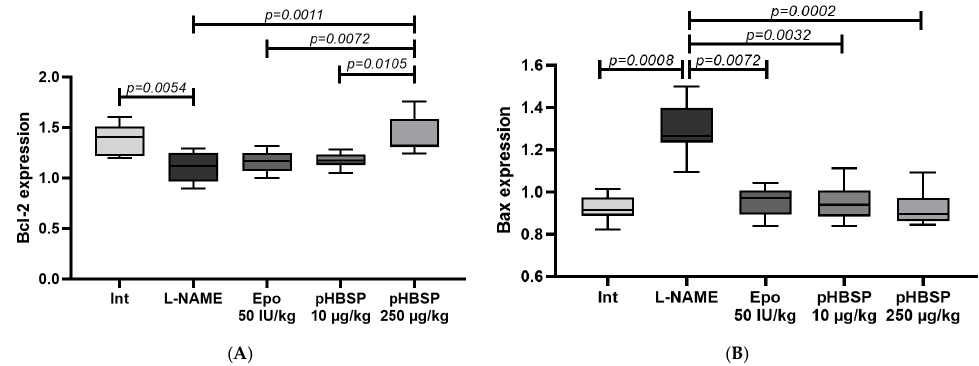
Figure 3. The effect of pHBSP on the proteinuria ( A ) and the fluid content in the greater omentum tissues ( B ) in animals with ADMA-like preeclampsia ( n = 10 animals in each group).